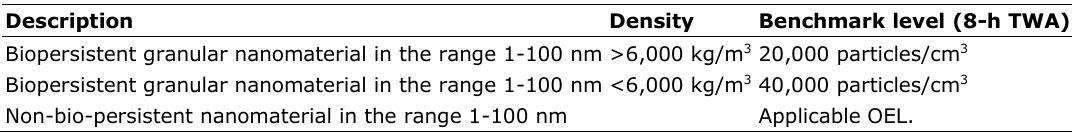
Table 2. Nano reference values, based on the benchmark level (IFA)(Deutsche Gesetzliche